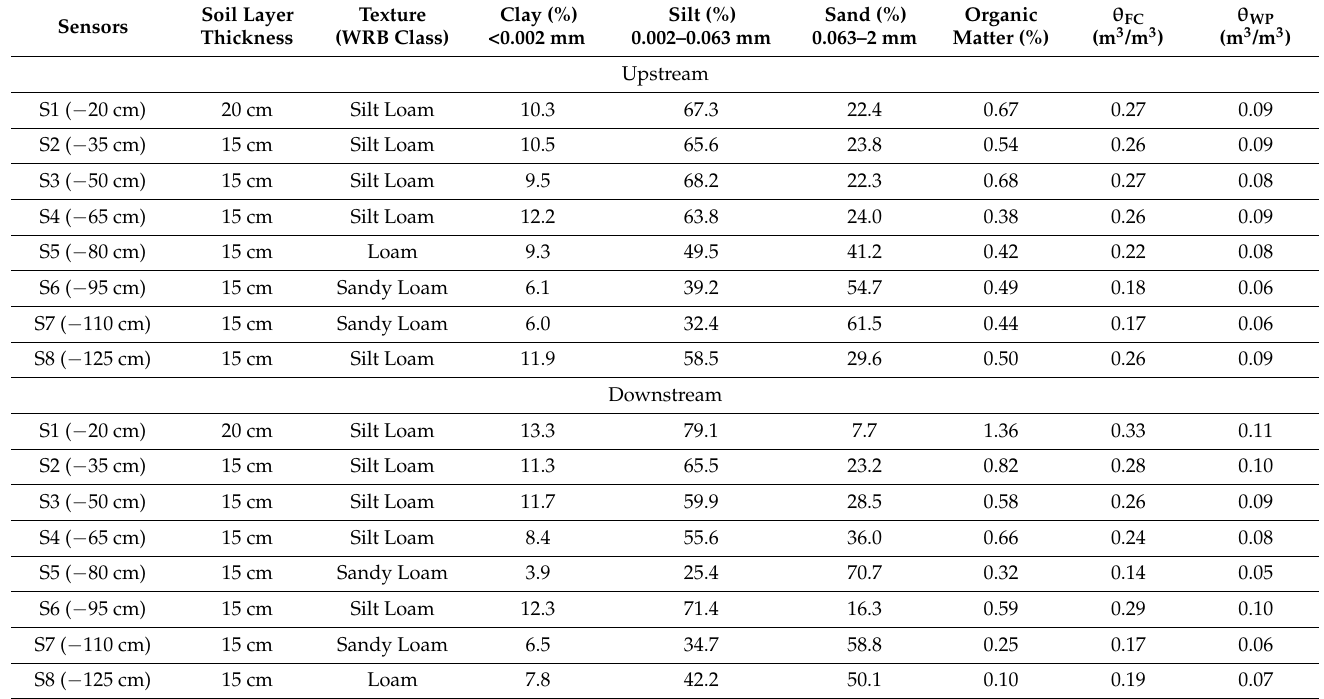
Table 2. Soil sample analysis for each layer in upstream and downstream profiles: texture class, organic matter content and soil moisture content at field capacity ( θ FC ) and at wilting point ( θ WP